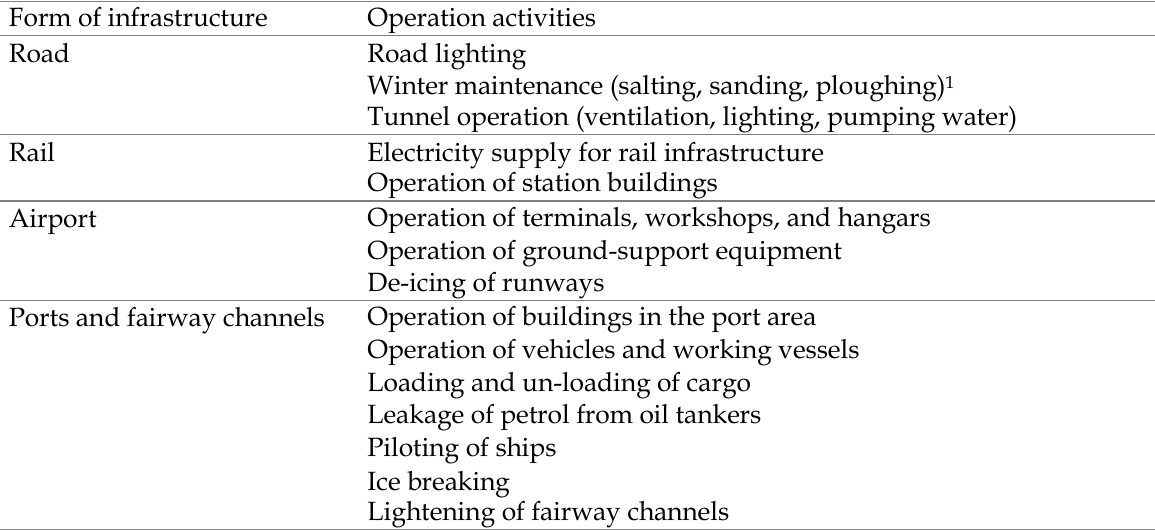
Activities included in operation of road and rail infrastructure, airports,